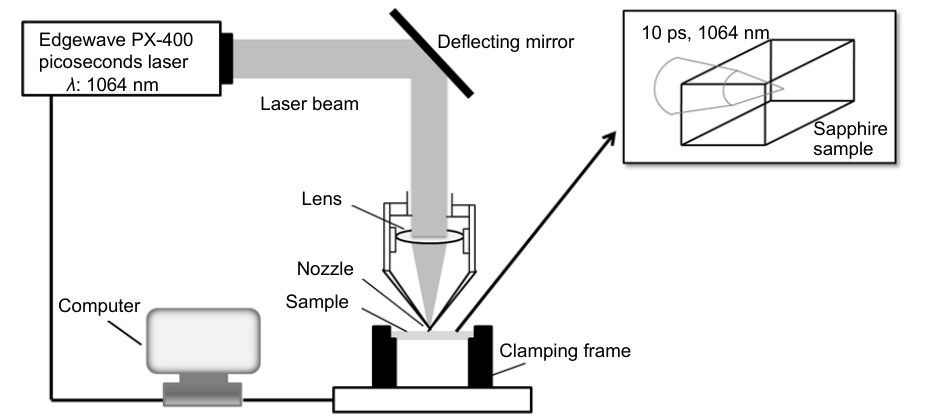
Fig. 1 | Schematic diagram of the experimental